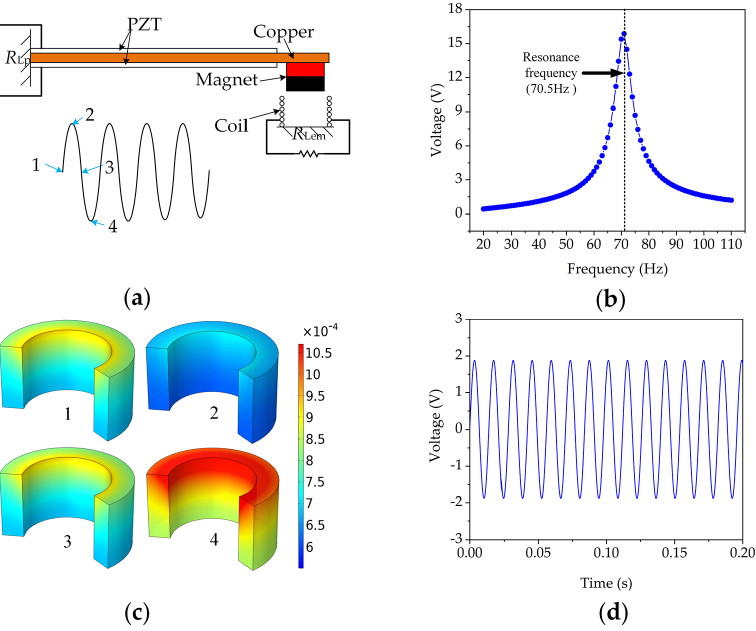
Figure 2. Simulation demonstration and result of a typical HEH: ( a ) schematic diagram and motion curve of a typical HEH; ( b ) open-circuit voltage of the PEG portion according to the input vibration frequency; ( c ) magnetic flux density (unit: T) in the coil at point 1, 2, 3 and 4; ( d ) open-circuit voltage of the EMG portion at 70.5 Hz.